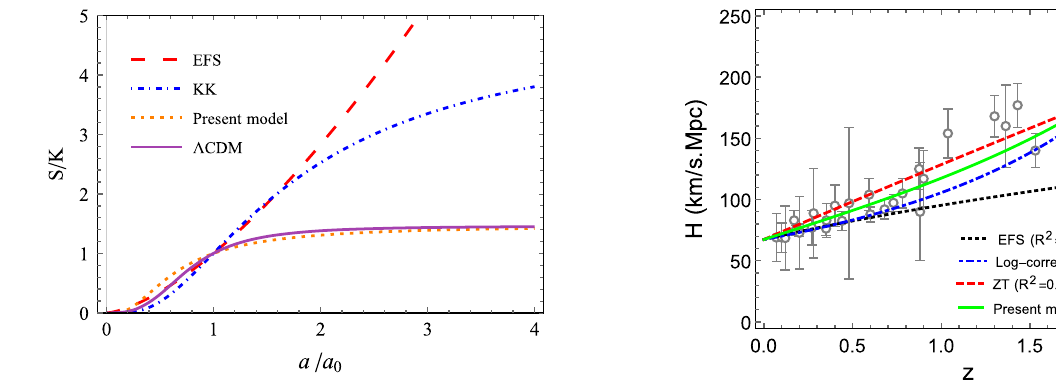
Fig. 6 Evolution of the Bekenstein–Hawking and generalized Fig. 7 Hubbleparameter H versusredshift z .Theopencirclewithbars entropies. The vertical axis represents dimensionless entropy, where the are data points taken from Table 1 in [37]. In all cases, the value of H 0 is parameter K is K BH = π k B c 5 / ¯ hGH 2 and K KK = π k B c 6 / ¯ hGH 3 , for settobe67 . 4km/s/MpcbasedonthePlanck2018results[38].Theblack 0 0 theBekenstein–HawkingentropyusedinEFSentropicmodel(EFS,red dotted curve is the first EFS entropic-force model [7] ( d = 2, Δ → 0, dashed curve) and generalized Komatsu-Kimura entropic-force model D d ,Δ = 0, C d = 1). The dot-dashed blue curve is the second EFS (KK, dot-dashed blue curve), respectively. The purple solid line rep- model [8] with logarithmic correction term ( d = 2, Δ → 0, C d = 1). resents S BH / K BH for the fine-tuned standard Λ CDM model and it is The fitting value is D d ,Δ = ( 0 . 1322 ± 0 . 0004 ) × 10 − 3 . The dashed analytically calculated from S BH / K BH = H − 2 = ( a / ˙ a ) 2 . K = k B A red curve is our previous thermodynamically consistent entropic-force for our generalized model with power correction term (orange dotted model [23] ( D d ,Δ = 0). The fitting value is C d = 0 . 57 ± 0 . 03. The curve).Dependingontheparameters,ourmodelpresentsdiversebehav- solid green curve is our present model with power correction. The best iors, ranging from curves similar to EFS model ( C d = 3 , D d ,Δ = fitting values are C d = 1 . 23 ± 0 . 03, D d ,Δ = ( − 0 . 005 ± 0 . 001 ) and − 0 . 25 , d = 2 ,Δ = 1 , E = 0), passing through Komatsu-Kimura d − Δ = 1 . 0 ± 0 . model ( C d = 3 , D d ,Δ = − 0 . 29465 , d = 3 ,Δ = 2 , E = 0), until a curve similar to the Λ CDM model ( C d = 3 . 3 , D d ,Δ = − 0 . 45 , d = 2 ,Δ = 1 , E = 0 . 01), which is the plotted orange dotted curve